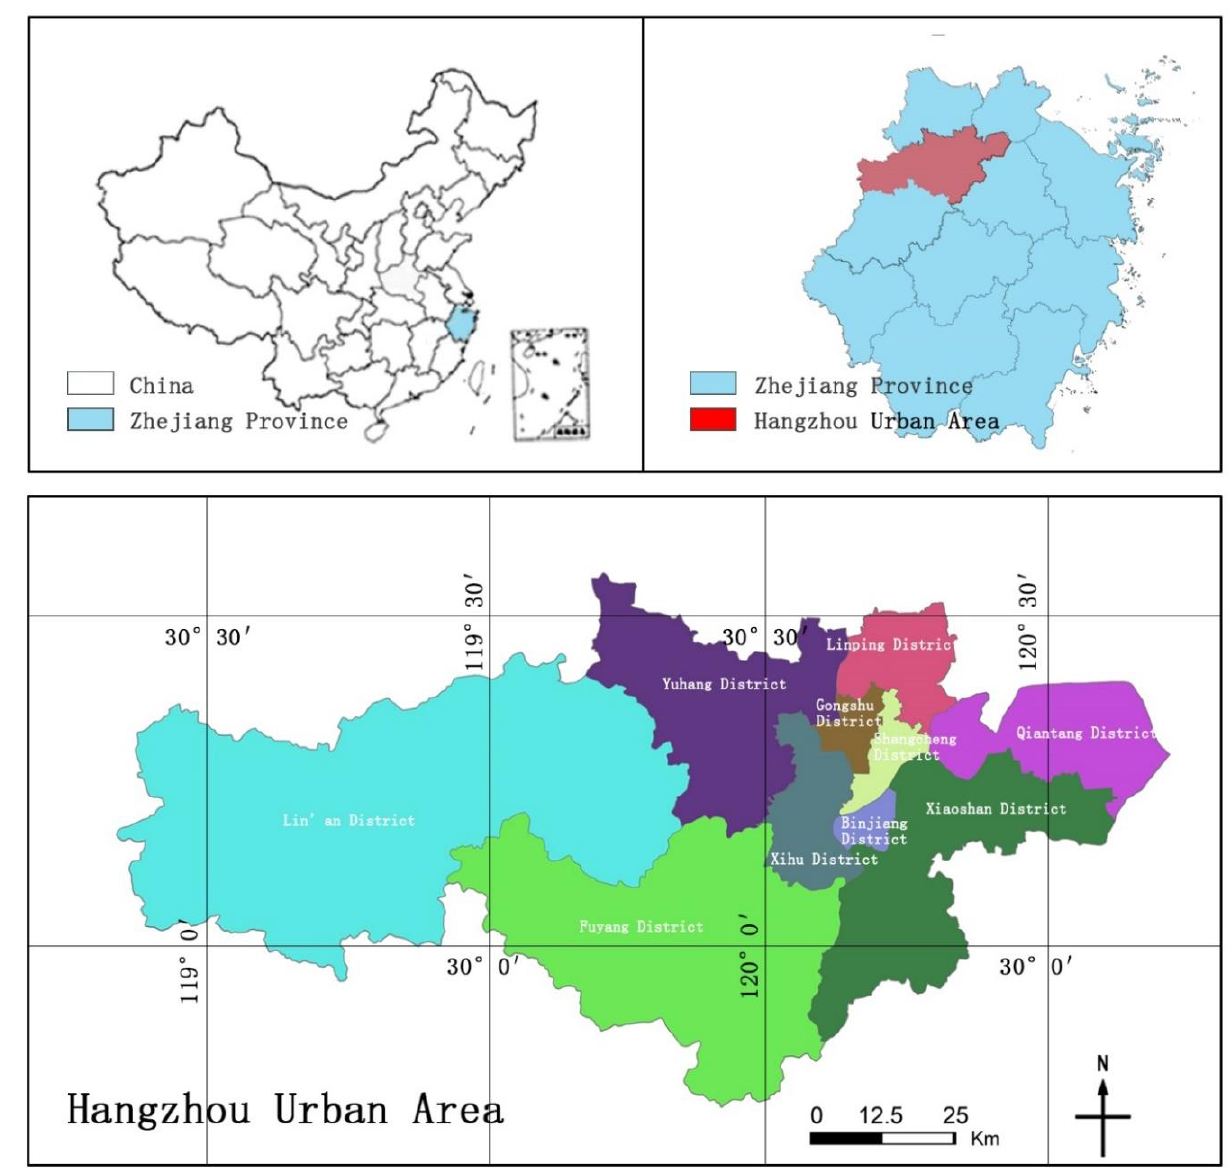
Figure 3. The location of Hangzhou Urban.